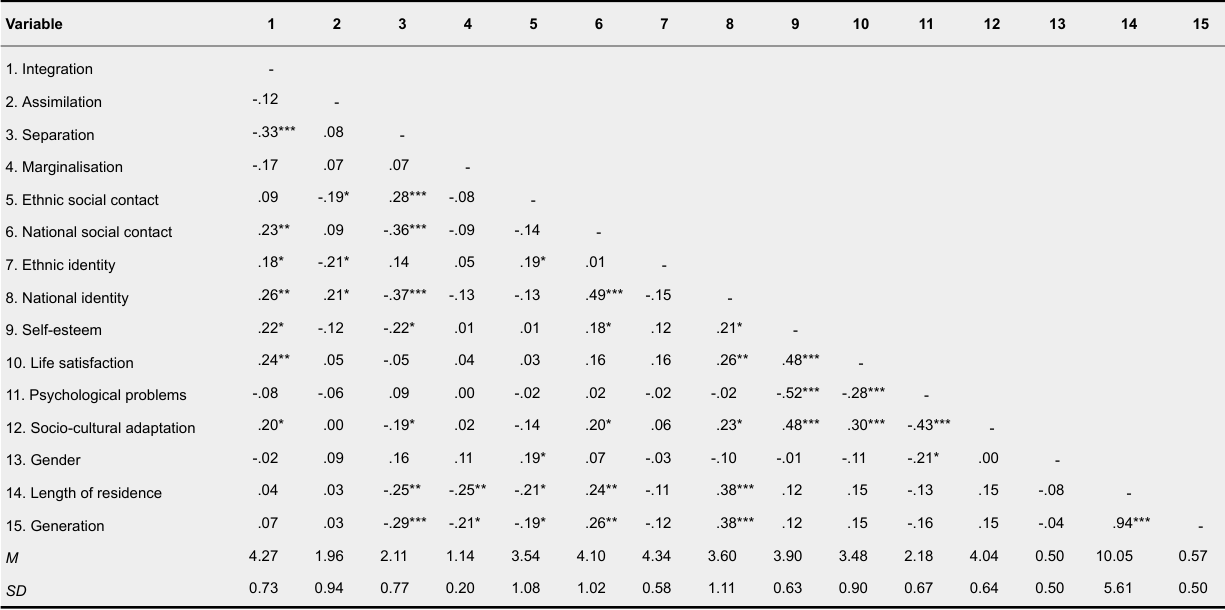
Means and Standard Deviations of, and Pearson Product-Moment Correlation Coefficients Between, Study Variables, for Tunisian Adolescents